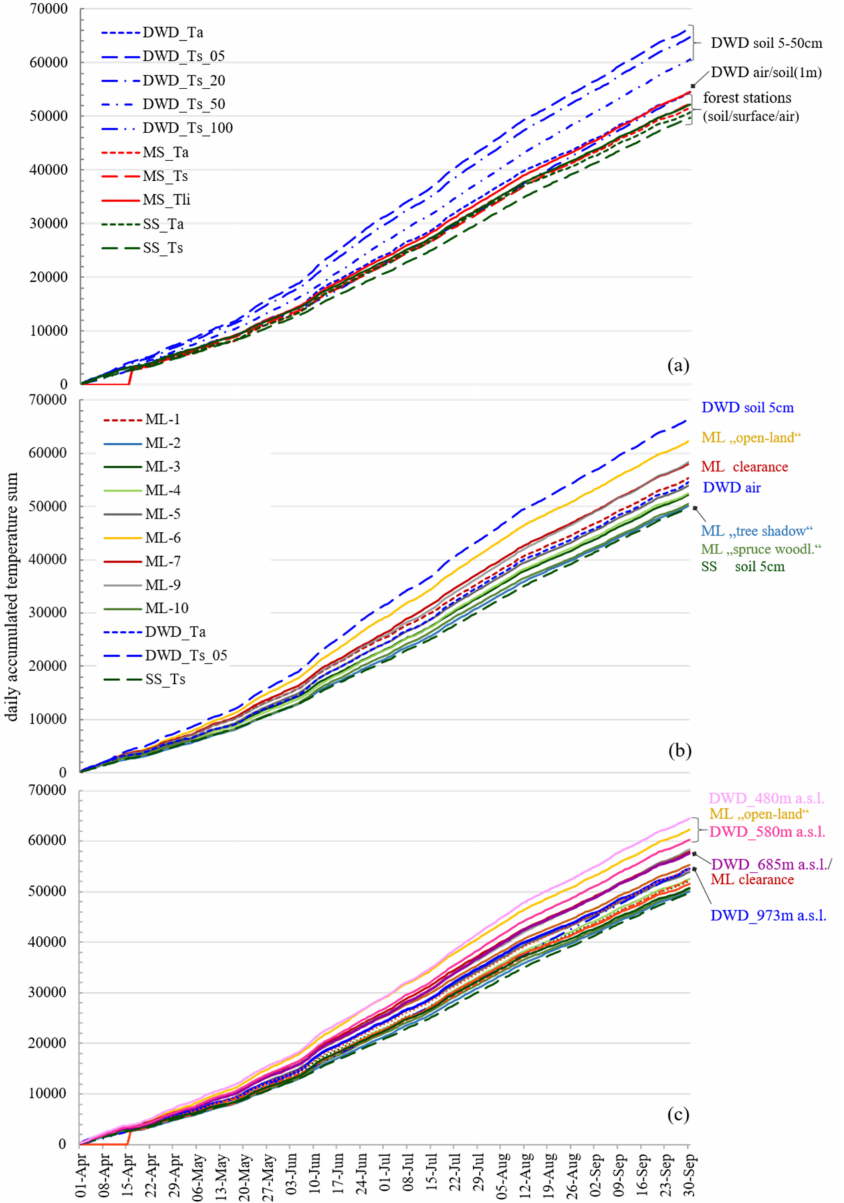
Figure 8. Accumulated temperature sum for the study period from April to September 2014. ( a ) Show- ing the nearby official weather station (DWD) and forest stations (Ts = soil, Ta = air, Tli = near-surface), ( b ) the Micro-Loggers (ML) and comparable measures of DWD and Small Station (SS) and ( c ) other official weather stations comparable to the warmest